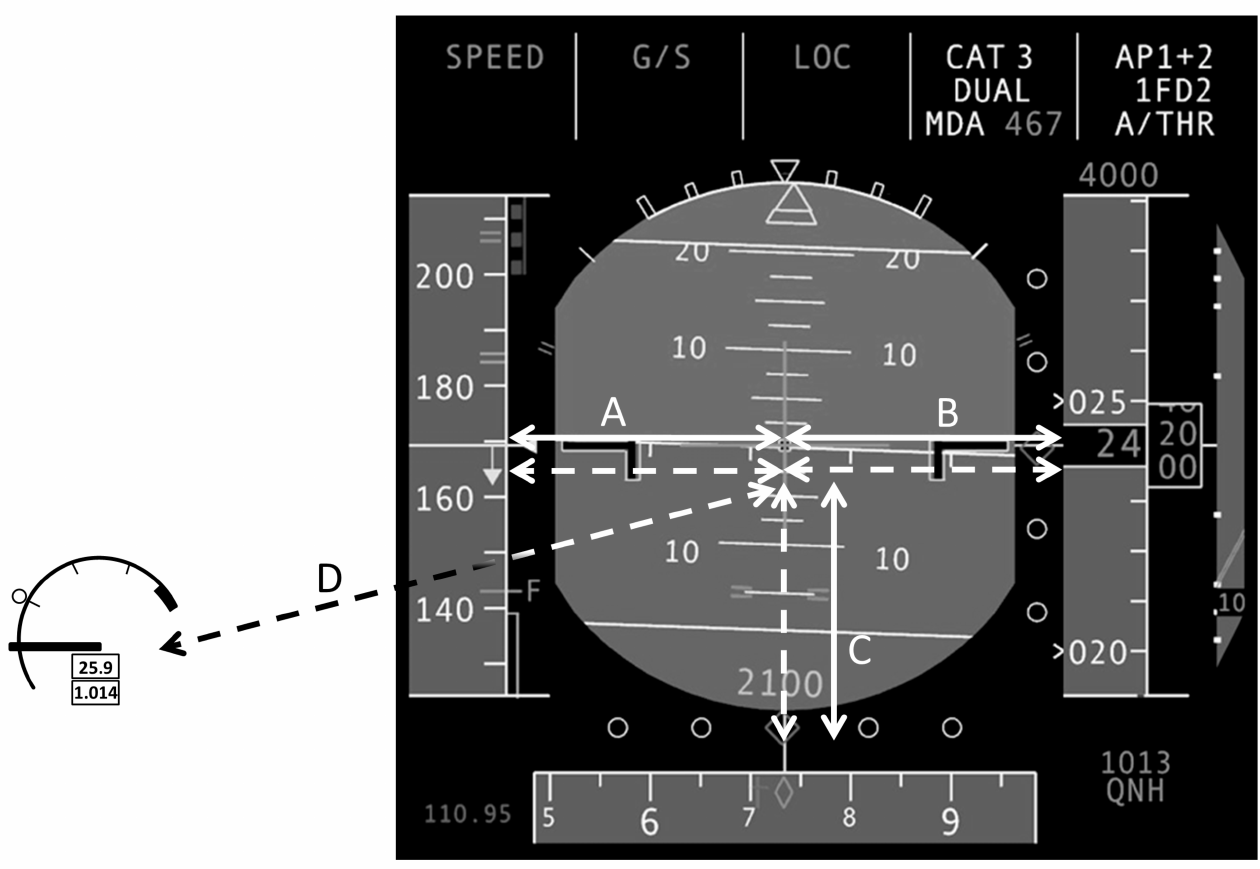
Figure 3. Representation of the four efficient visual scanning patterns, as displayed to the experimental group. These visual scanning patterns were related to (as presented Table 1) the speed (visual scanning pattern ( A )), the vertical deviation (visual scanning pattern ( B )), the lateral deviation (visual scanning pattern ( C )), and the general attitude of the aircraft including engine (visual scanning pattern ( D )). Patterns represented in solid lines ( A – C ) are more frequently performed than the pattern represented with dashed lines ( D